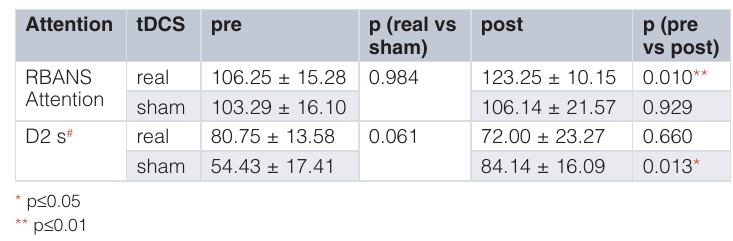
Table 4. Pre- and postscores and p-values of the attention and vigilance assessments per